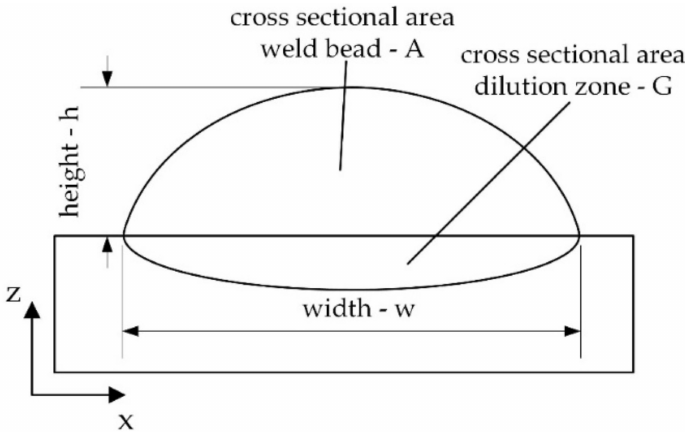
Figure 8. Geometrical features of single LMD weld